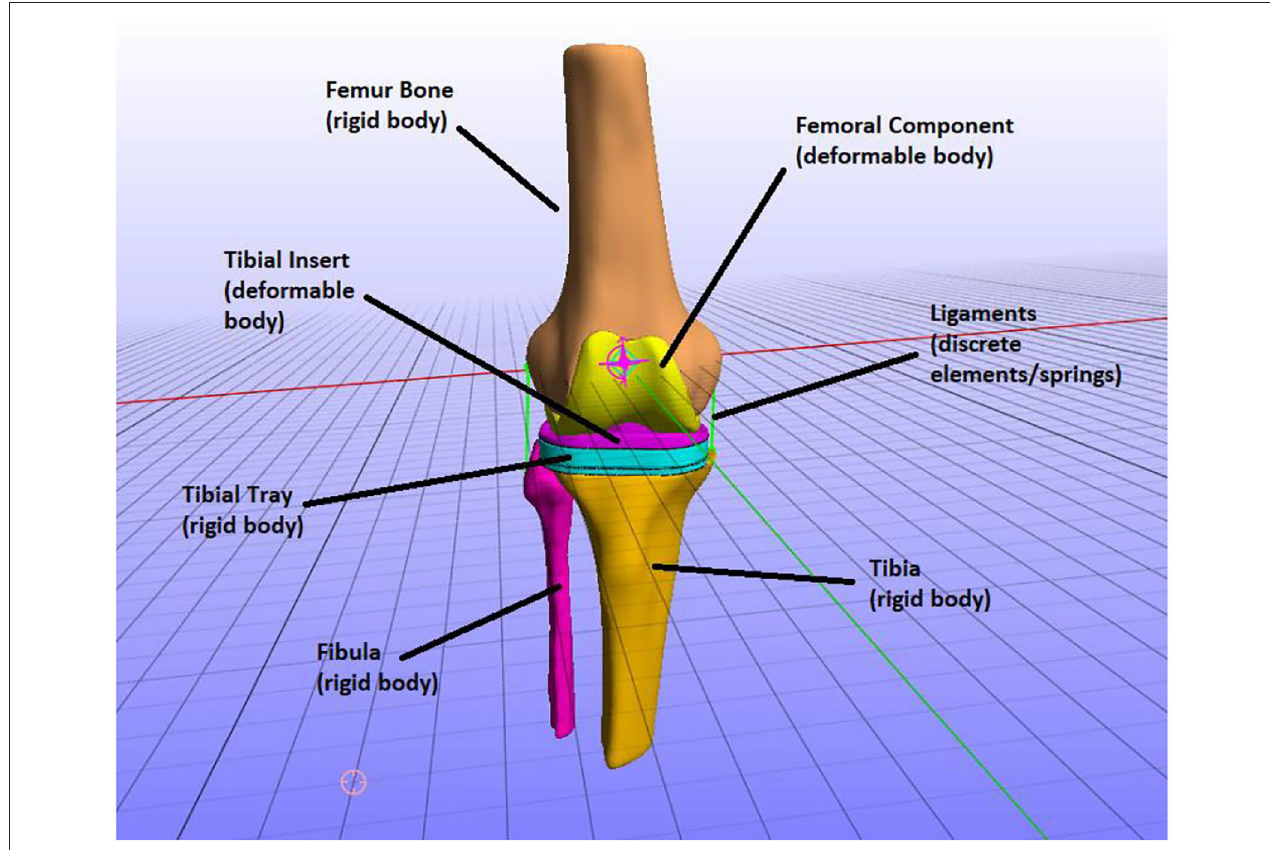
FIGURE 6 | The parts of the finite element (FE) model, i.e., knee bones and implant parts and how they were modeled (e.g., the tibia was modeled as a rigid body).